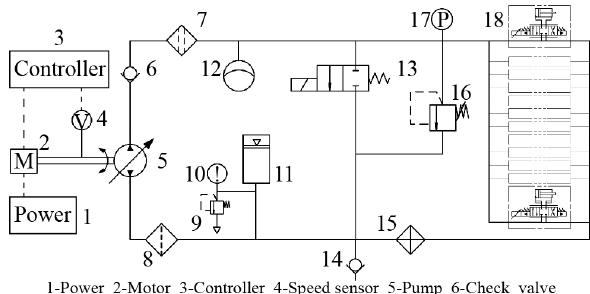
Figure 3. Schematics of the hydraulic actuation system.